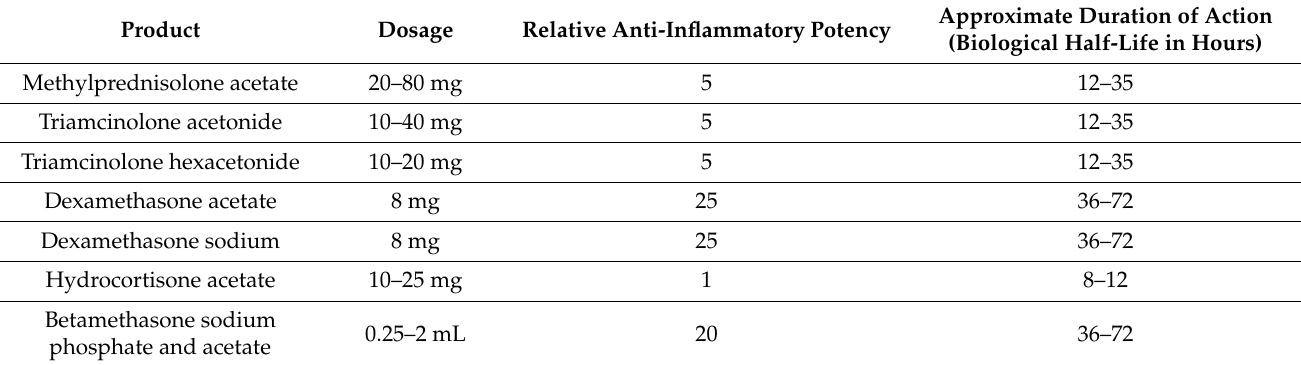
Table 1. Varieties of corticosteroids and